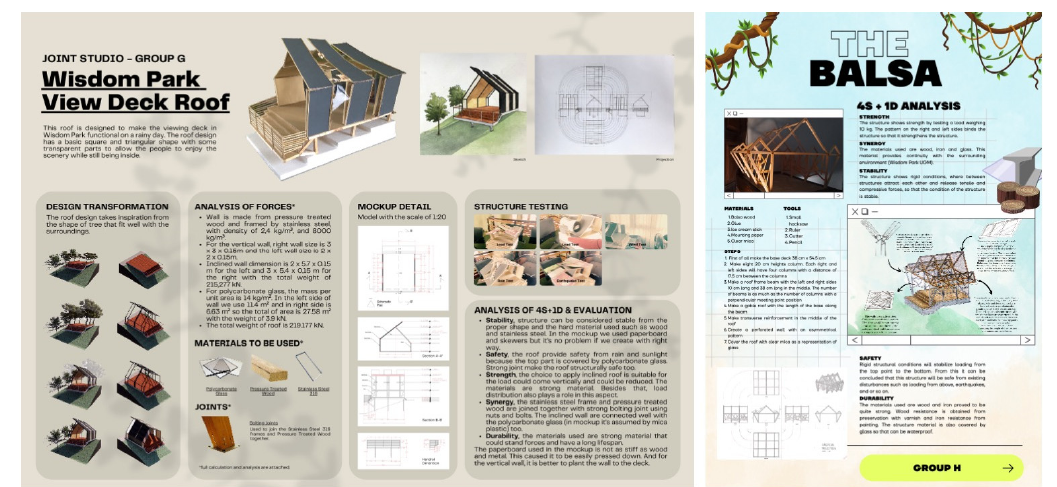
Figure A5. Chaoroof.